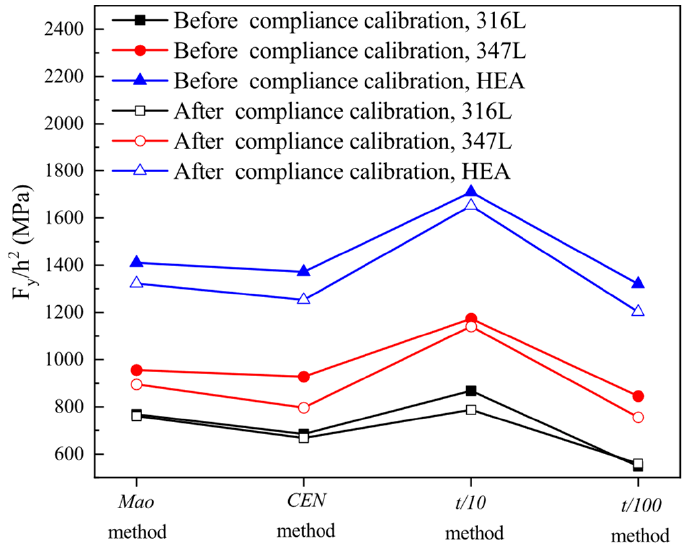
Figure 13. Different methods for determining the F y .